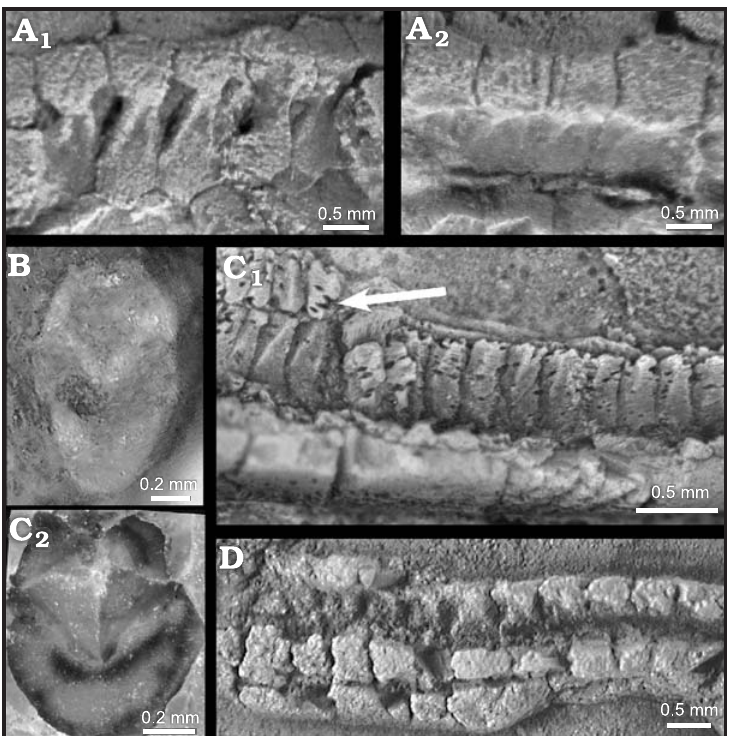
Fig. 7. Slat-like ambulacral floor plates of Early Ordovician echi- noderms expressing podial basins, pores. A . Ambulacral details of edrioasterid Paredriophus elongatus Guensburg and Sprinkle, 1994 (PE 52740), Utah, USA. Wedge-shaped pore slits bordered by raised rims (A 1 ); pore slits filled with syntaxial overgrowths (A 2 ). B . Undescribed Porocrinus -like cyathocrinine cladid (NPL 1977TX12), Nevada, USA; natural break across distal ?A ray arm showing cross section, floor plates, hints of podial pores, pattern similar to disparid taxon A. C . Disparid taxon A (PE 52752), Fillmore Formation, Utah, USA; specimen with intact arm and stem segments strewn over and within a limestone slab, attributed to taxon A using overlapping morphology of five other strati- graphically associated specimens. Slat-like floor plates showing wedge-shaped pores with attenuated rims, well-preserved on left, with open cover plates above (arrow) (C 1 ); polished cross-sec- tion of arm, plates slightly ajar with dark syntaxial overgrowths, cover plates, floor plates, large coelomic space (C 2 ). D . Cladid Apektocrinus ubaghsi Guensburg and Sprinkle, 2009 (TMM 1983TX1), Idaho, USA; B ray mid-arm segment with weathered slat-like floor plates and podial